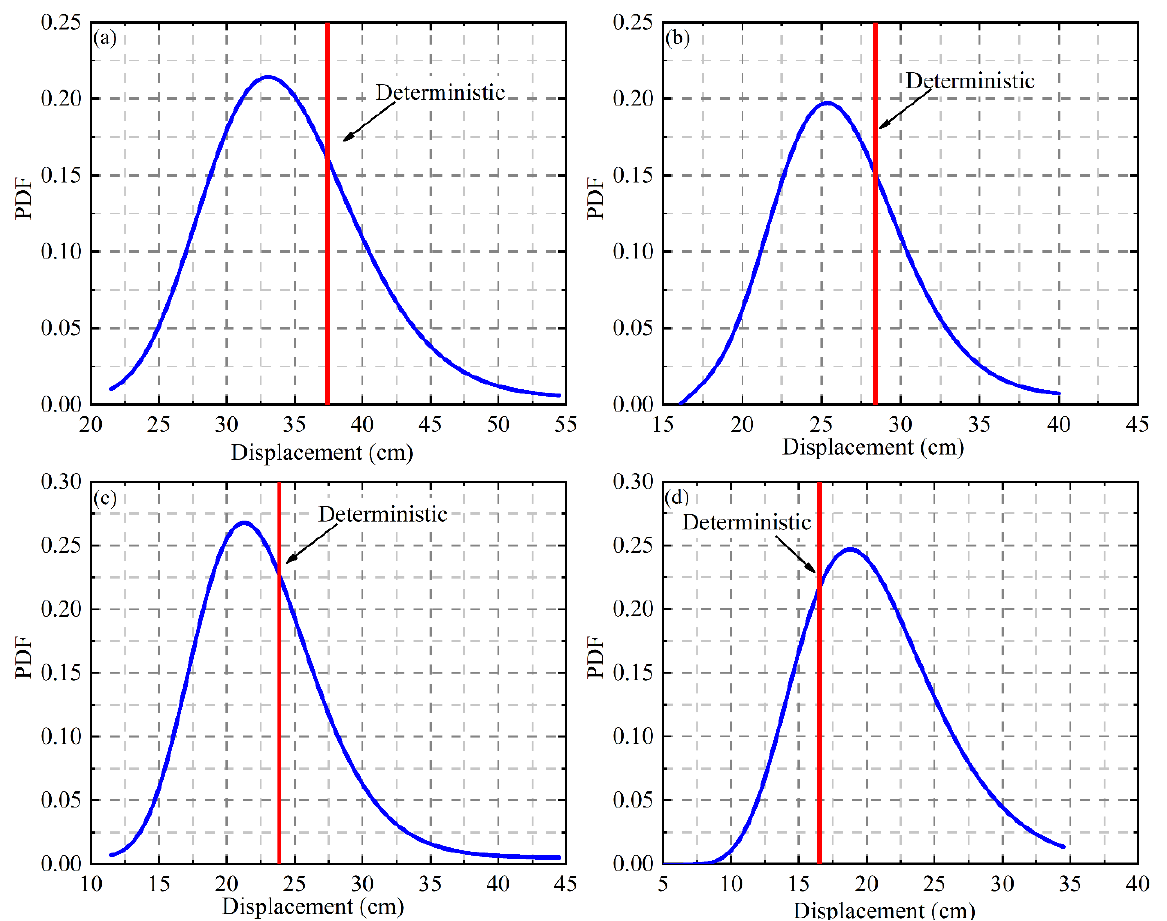
Figure 14. PDF of the peak value of tunnel uplift displacement at different embedment depths: ( a ) H = 6 m; ( b ) H = 8 m; ( c ) H = 10 m; ( d ) H = 12 m.